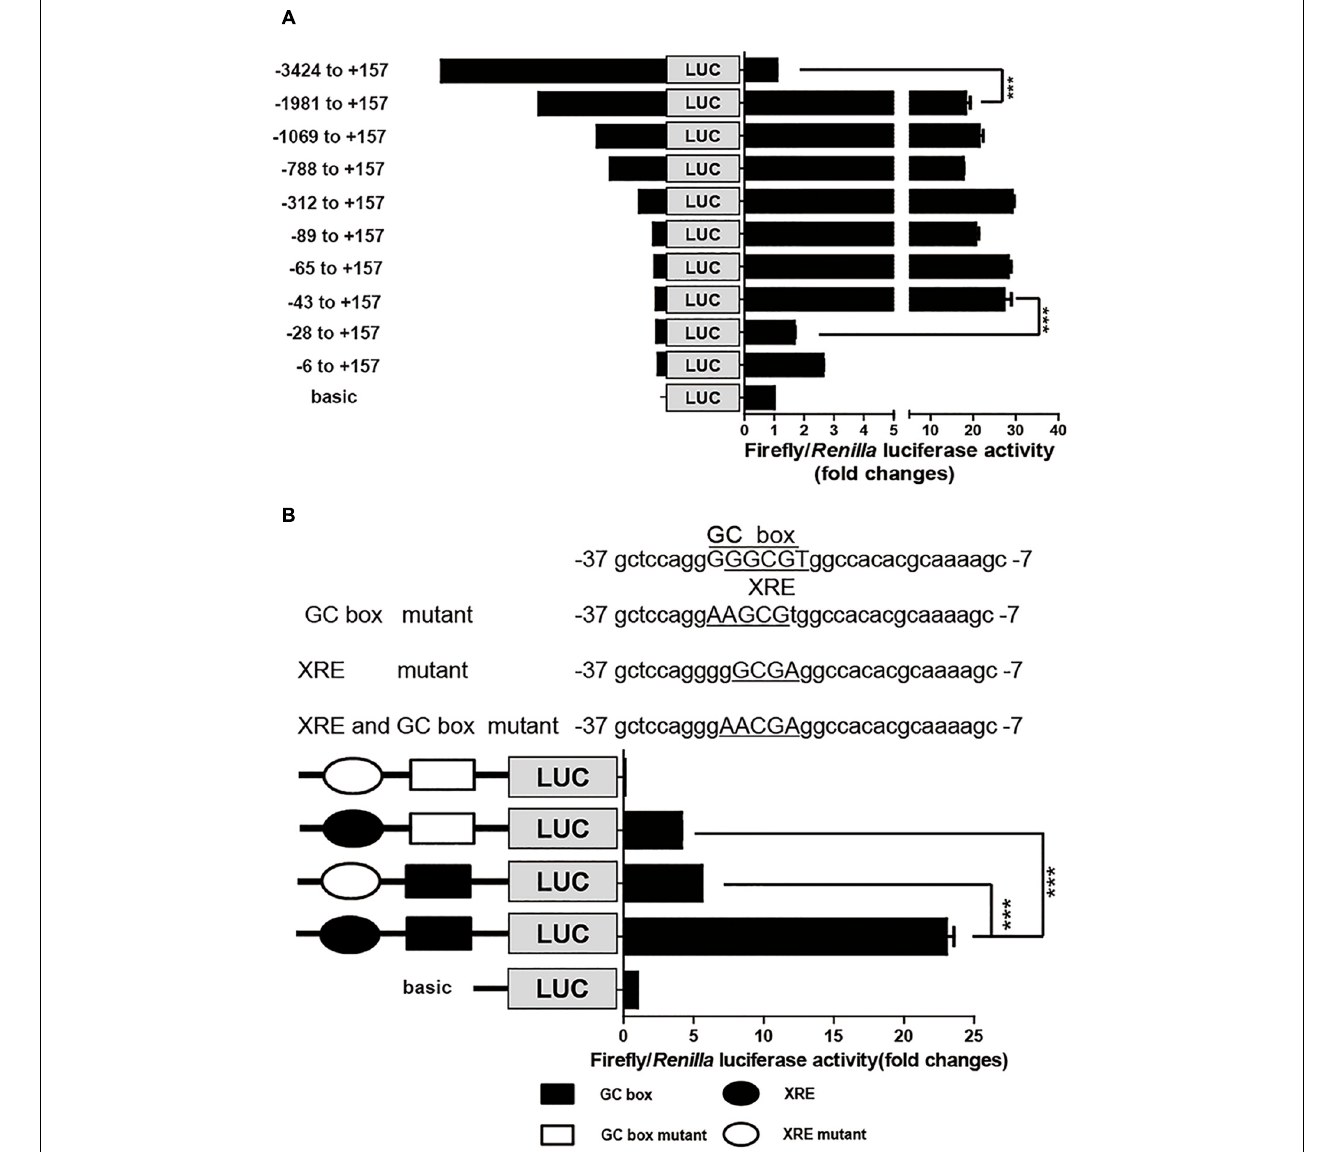
FIGURE 1 | The proximal GC box and XRE determine p CYP1A1 basal expression. (A) Deletion analysis of the p CYP1A1 promoter in LLC-PK1 cells. pGL3-basic containing different lengths of the p CYP1A1 promoter fragments and pRL-CMV plasmid were transfected into LLC-PK1 cells, and the luciferase activities were measured, as described in section “Materials and Methods.” Basic represents empty vector pGL3-basic, which served as the control. The values on the right show the ratio of the luciferase activity of the promoter fragment to the luciferase activity of pGL3-basic. The left diagrams show the deletion pattern of the p CYP1A1 promoter. The number indicates the position of the fragment (base pair) at the transcription start site. (B) Mutation analysis of the proximal p CYP1A1 promoter in LLC-PK1 cells. The mutation pattern is shown above and represent the mutations that are introduced into the –37 to –7 promoter region to destroy the XRE and GC box. The mutated bases are underlined. The left diagram shows the mutation pattern of the p CYP1A1 promoter. The value on the right shows the ratio of the luciferase activity of the promoter fragment to the luciferase activity of pGL3-basic. The experiment was repeated three times. Error bars represent the standard deviation of three replicates. ∗∗∗ P <